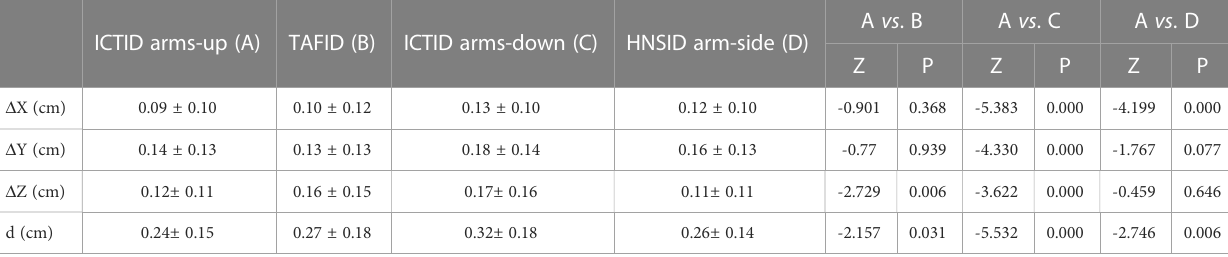
HNSID, head-neck-shoulder immobilization device; ICTID, integrated cervicothoracic immobilization devices; TAFID, thoracoabdominal fl at immobilization device. Z < -1.96 is considered statistically signi fi cant; P<0.05 is considered statistically signi fi